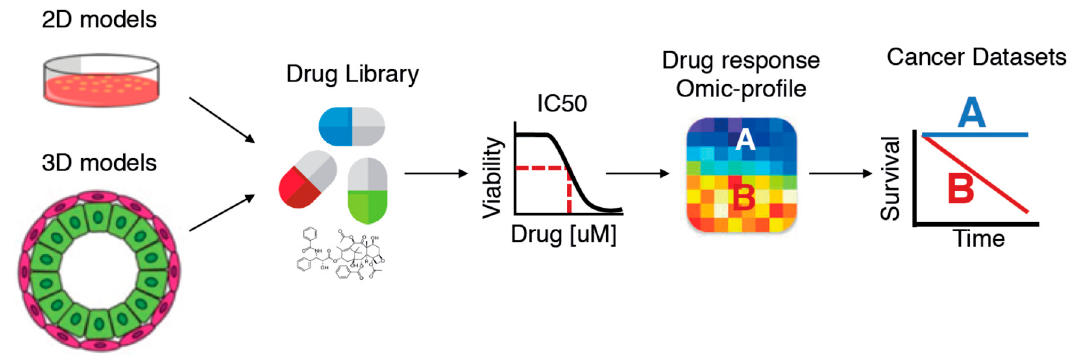
Figure 3. Drug library screening using 2D and 3D lung cancer models can unveil cancer biomarkers predictive of chemotherapy response. Cells are treated with different concentration of the tested compounds and the IC50 (i.e., the concentration at which cell proliferation was inhibited by 50%) is computed to determine chemoresponsivness of every cell line (i.e., sensitive vs. resistant). Next, a molecular profile analysis (e.g., gene expression, mutational, protein expression, methylation) can be performed in order to identify a signature correlating with chemoresponsivness, which can be eventually applied to cohorts of patients, to predict their response to treatment and/or to identify actionable